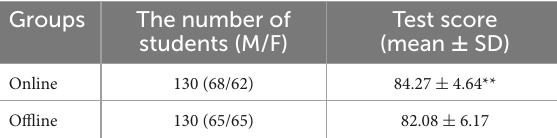
TABLE 1 The average score of the